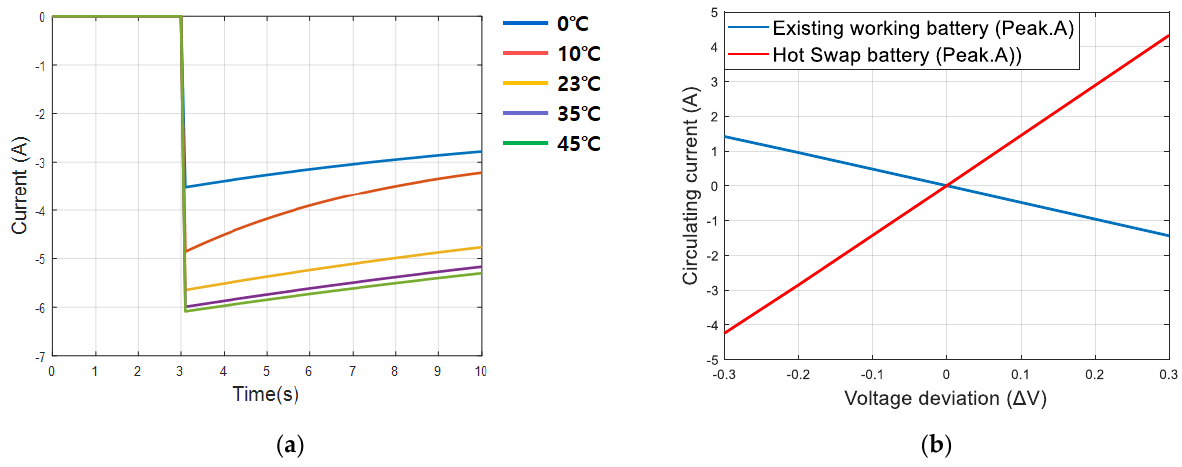
Figure 13. Influence of battery statements on hot swap circulating current ( a ) at various temperatures and ( b ) as a function of the voltage deviation.